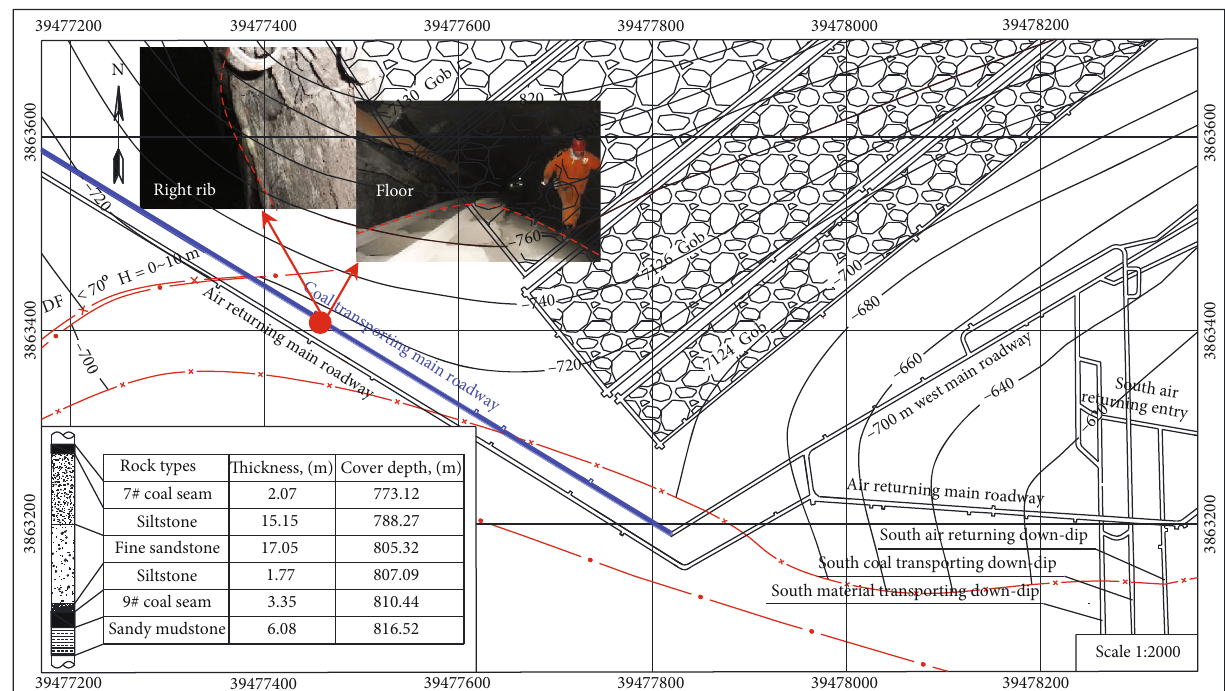
Figure 2: Layout of the test site in the Sanhejian coal mine. The lower-left corner gives the borehole columnar section of the test roadway. The thick blue line represents the test roadway position. The red solid point is the location where these roadway deformation photos were